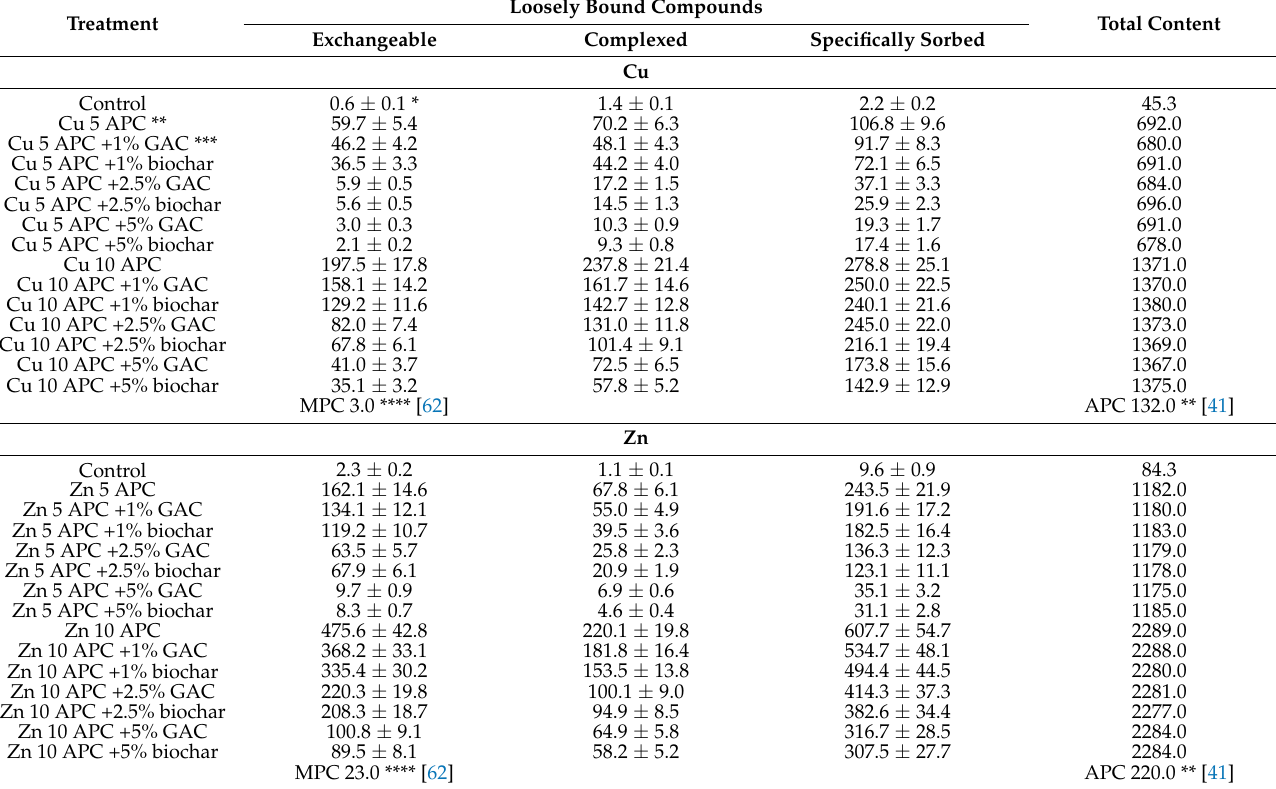
* Values represented are averages ± standard deviation; the number of replicates corresponded to three ( n = 3). ** APC—approximate permissible concentrations for the total heavy metal (HM) content. *** GAC–granular activated carbon. **** MPC—maximum permissible concentrations for exchangeable HM